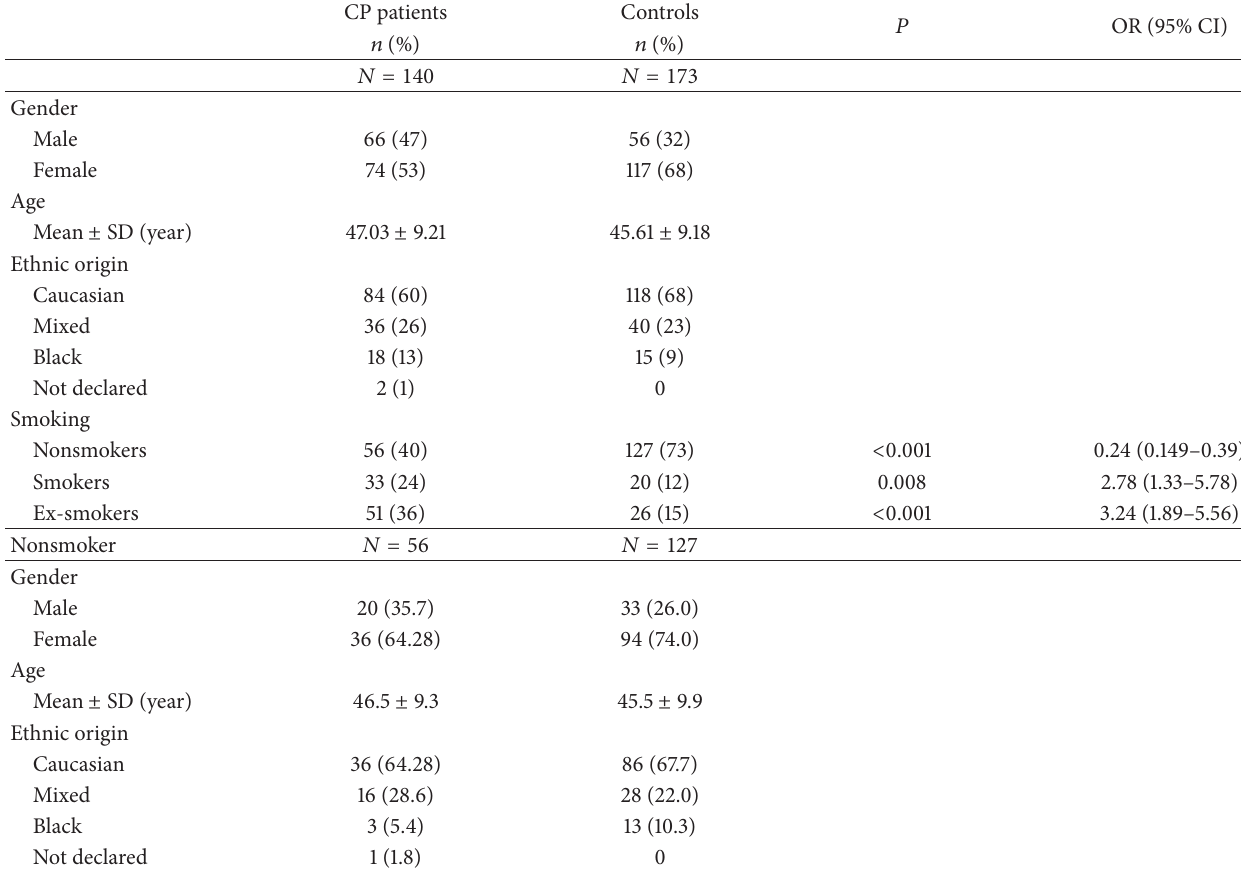
Table 1: Characteristics of patients with chronic periodontitis (CP) and